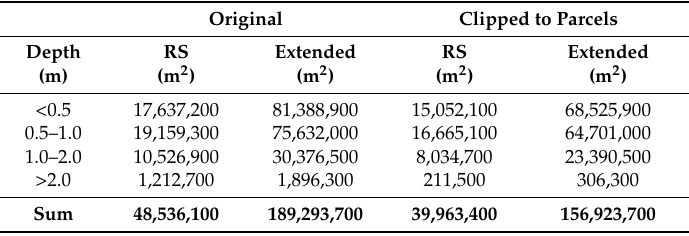
Figure 9. The obtained flood depth map. ( a ) Clipped to the flooded polygons delineated with the RS methodology; and ( b ) extended in the entire affected area. Table 3. Flooded area statistics for the original and the clipped flood depth maps and for the cases that the flooded areas are limited to the flooded polygons delimited by RS or are extended outside the boundaries of the delimited polygons